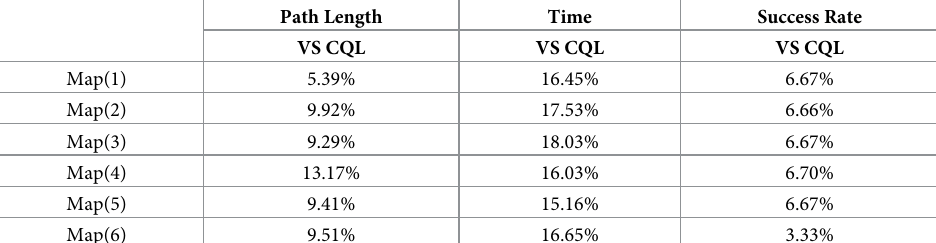
Fig 11. Mean path length of different algorithms in improved grid map for SAR robot. https://doi.org/10.1371/journal.pone.0283751.g011 Table 4. Comparison of performance between FIQL and CQL in typical grid